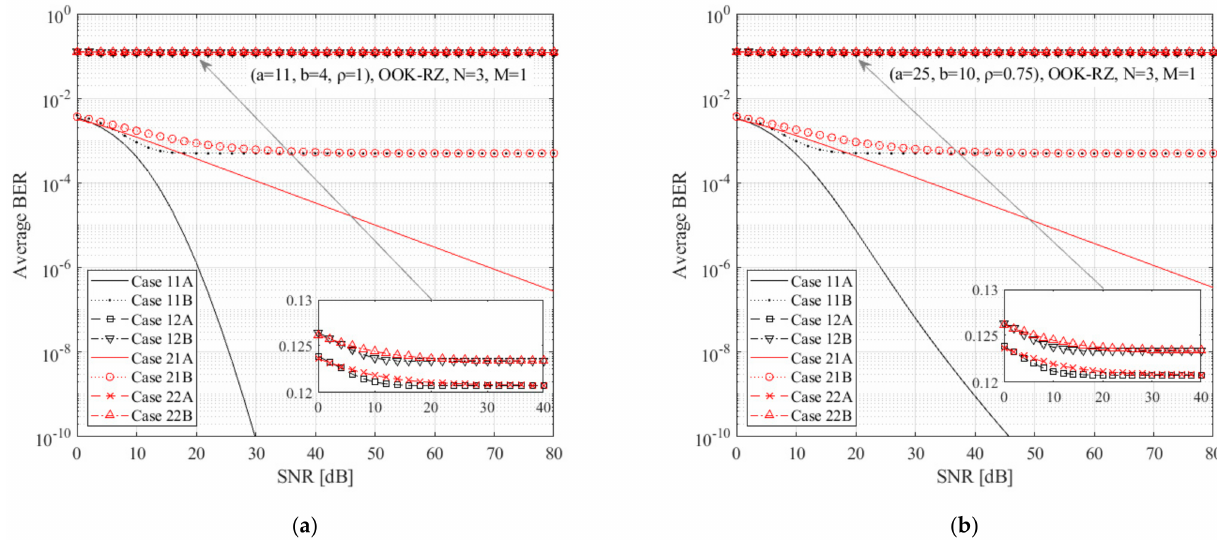
Figure 2. ABER versus expected SNR for the OOK-RZ scheme, N = 3, M = 1, with various bit rates and spatial and time jitter conditions of ( a ) ( a = 11, b = 4, ρ = 1) and ( b ) ( a = 25, b = 10, ρ = 0.75). The studied curve cases are codified as follows: Case 11A: ξ = 5.03, σ = 5.815 × 10 − 9 s, 48 Mbps; Case 11B: ξ = 5.03, σ = 29.075 × 10 − 12 s, 24 Gbps; Case 12A: ξ = 5.03, σ = 1.163 × 10 − 6 s, 48 Mbps; Case 12B: ξ = 5.03, σ = 5.815 × 10 − 9 s, 24 Gbps; Case 21A: ξ = 0.59, σ = 5.815 × 10 − 9 s, 48 Mbps; Case 21B: ξ = 0.59, σ = 29.075 × 10 − 12 s, 24 Gbps; Case 22A: ξ = 0.59, σ = 1.163 × 10 − 6 s, 48 Mbps; and Case 22B: ξ = 0.59, σ = 5.815 × 10 − 9 s, 24